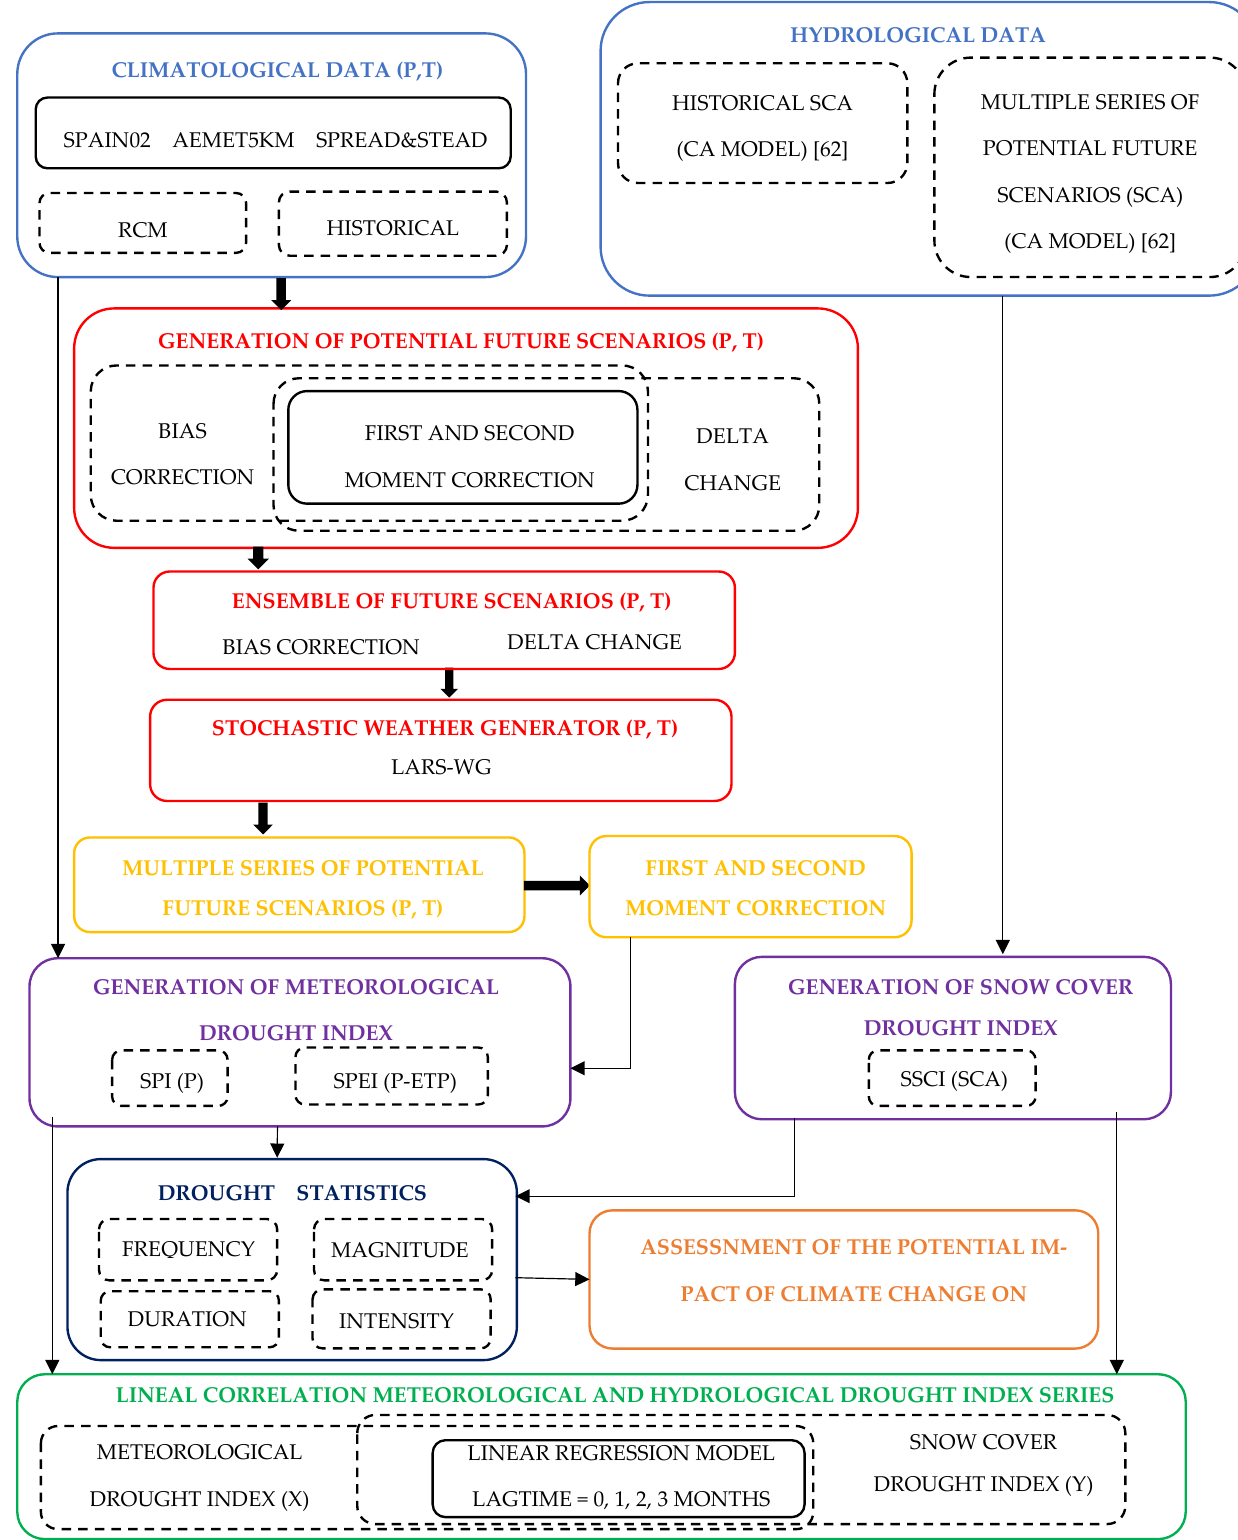
Figure 4. Methodology flowchart [62].